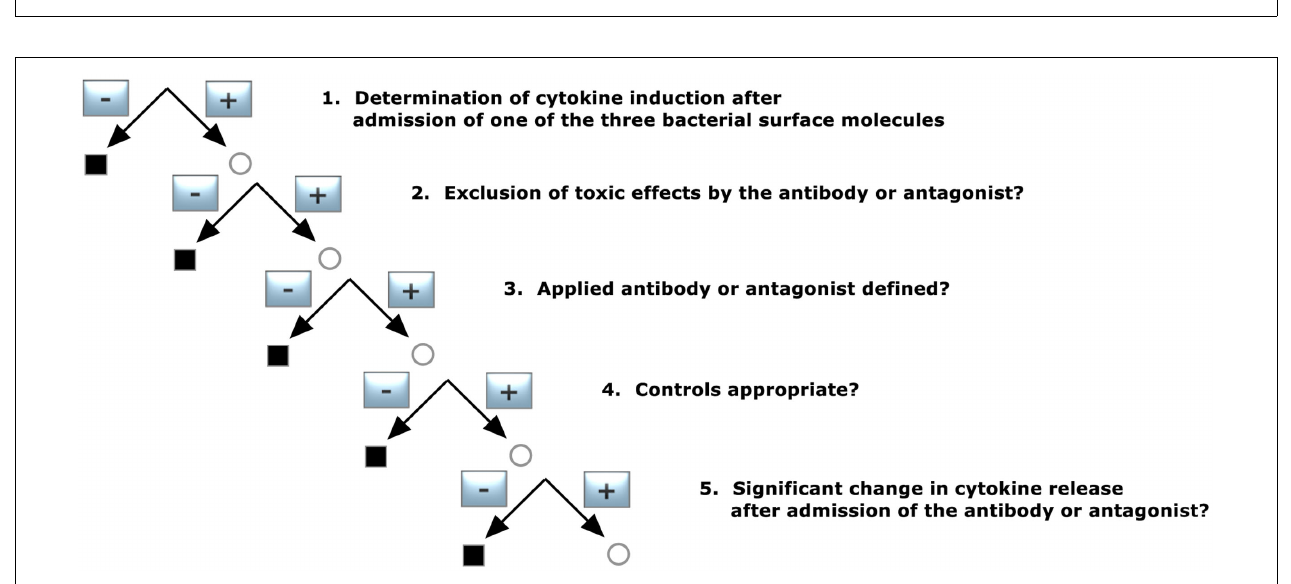
FIGURE 4 | Decision tree 4 (Koch–Dale criterion 3).